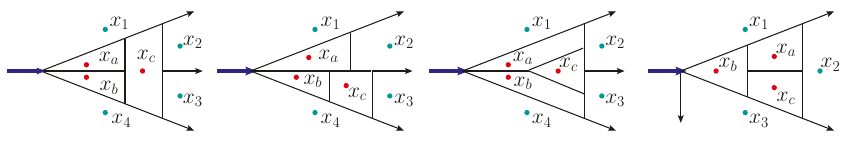
Figure 12. Trivalent topologies for the three-loop form factor of tr( φ 3 ) .